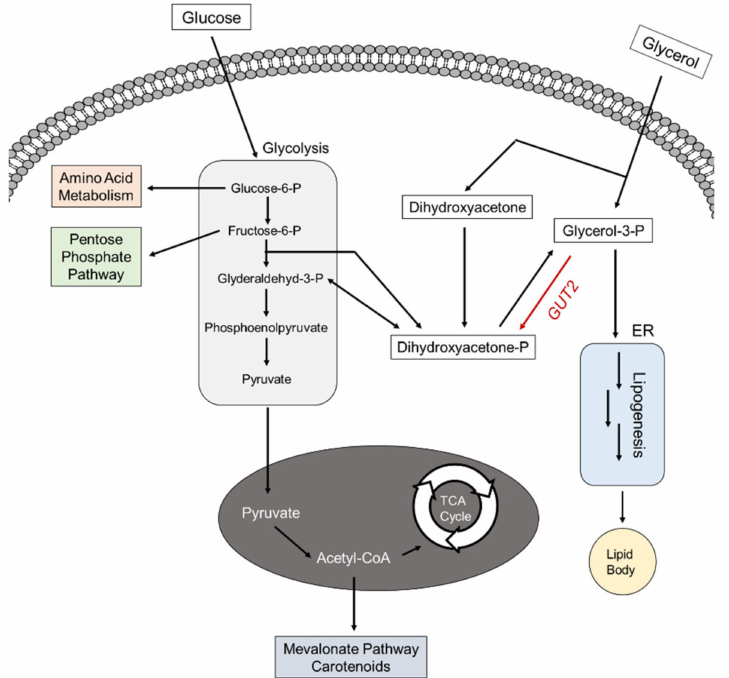
Figure 1. Simplified overview of glucose and glycerol metabolism in Yarrowia lipolytica with key metabolites highlighted. GUT2 = glycerol-3-phosphate dehydrogenase. Figure based on results from: